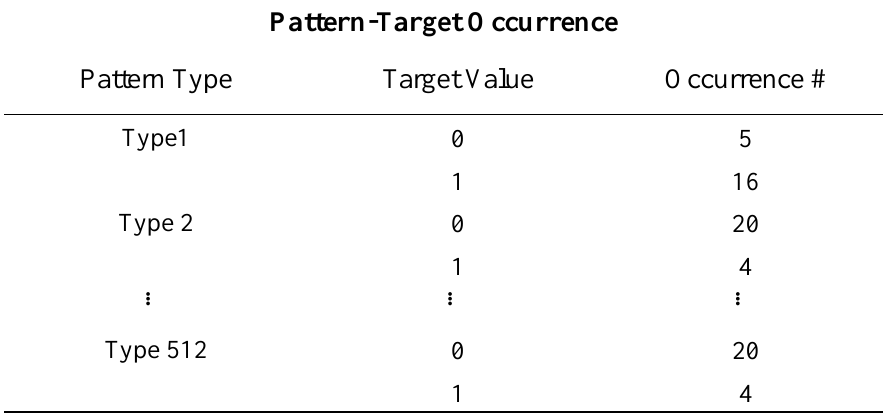
Table 2. Pattern-target occurrence table.